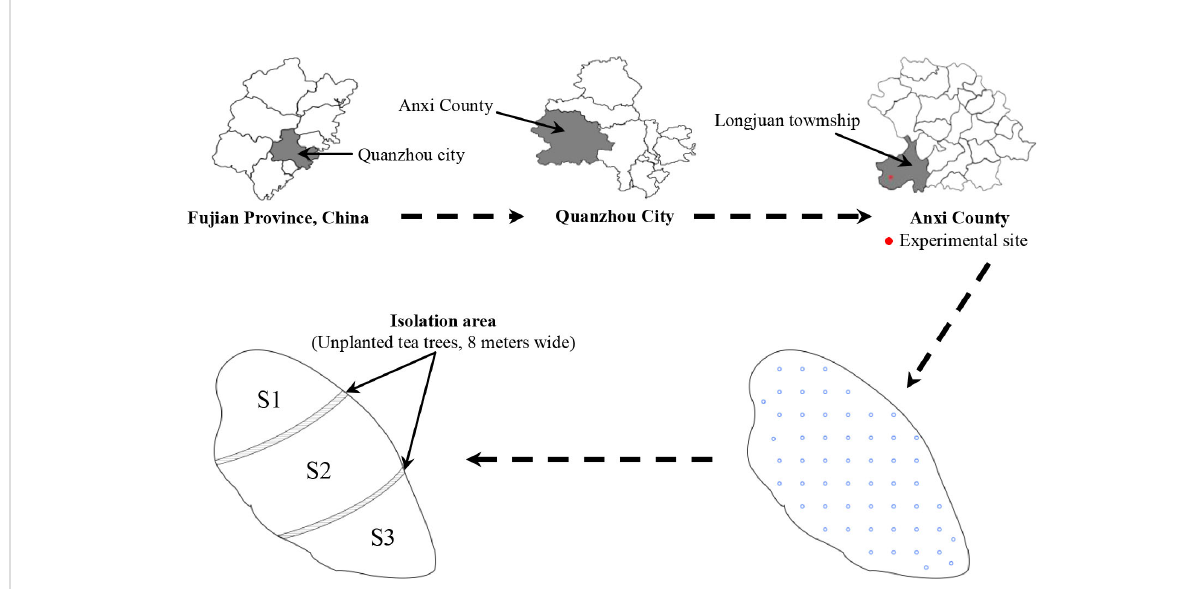
FIGURE 1 Schematic diagram of experimental site and tea plantation